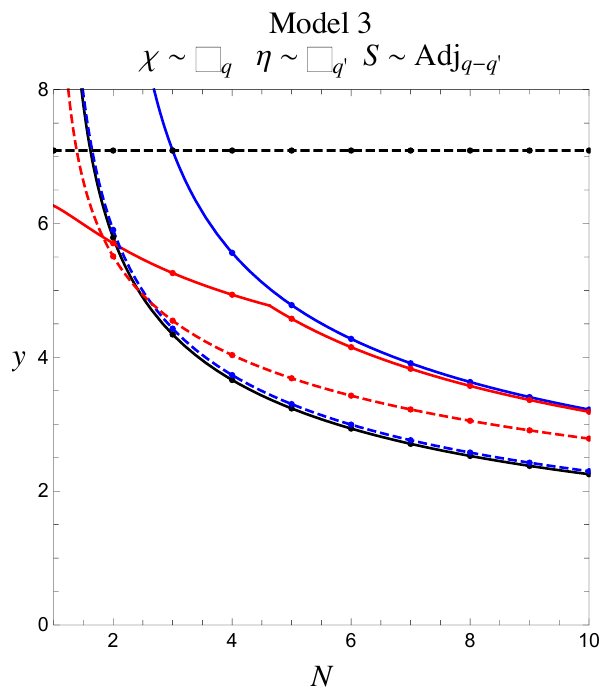
Figure 9 . PU bounds on the Yukawa couplings y for the model 3 of the Dirac type class for J = 0 (black), J = 1 / 2 (blue) and J = 1 (red). The solid (dashed) lines correspond to the case of a real (complex) scalar field. The dashed blue is slightly moved for presentation since it overlays exactly with the solid